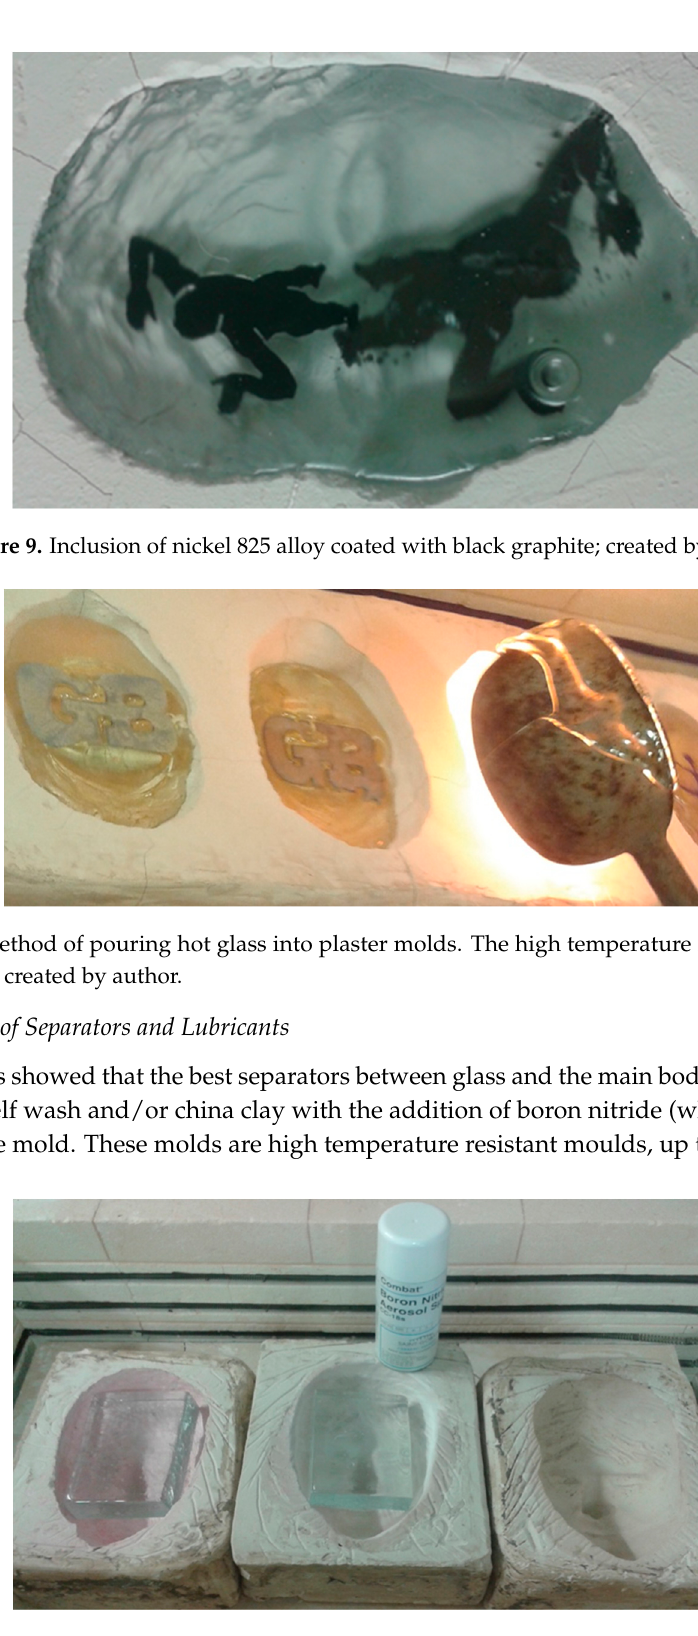
Figure 8. Silver flakes used as a lubricant to prevent oxidation of metal inclusions; created by author.